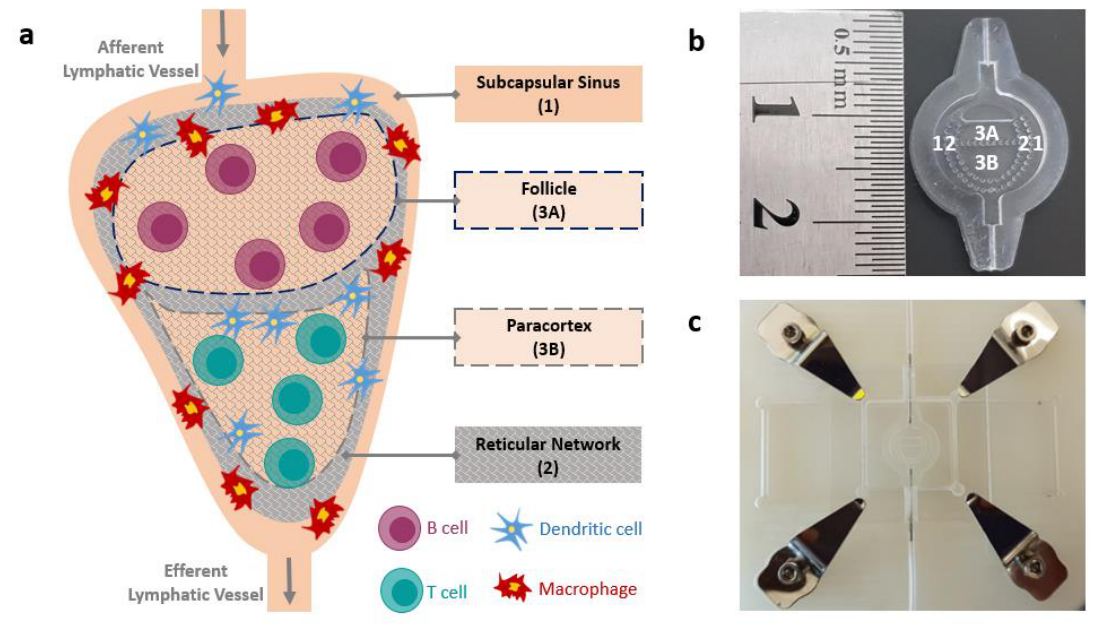
Figure 1. Artificial biomimetic LN-on-a-chip. ( a ) Schematic of the human LN showing the key anatomical features. ( b ) LN-on-a-chip designed to mimic the human LN. Region labelled 1 resembles the subcapsular sinus, region labelled 2 resembles the reticular network, region labelled 3A resembles the follicle, and region labelled 3B resembles the paracortex. Regions 3A and 3B are the cellular regions loaded with immune cells embedded in 3D hydrogel matrices. ( c ) The clamping system used to seal the device and produce a functional system that can be loaded with immune cells.